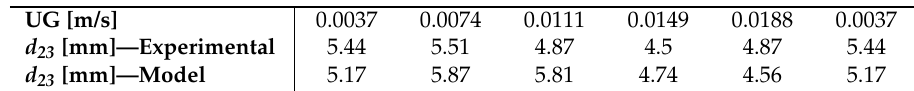
Table 1. Comparison between the population balance model (PBM) results and experimental data: Sauter mean diameter, d 23 .